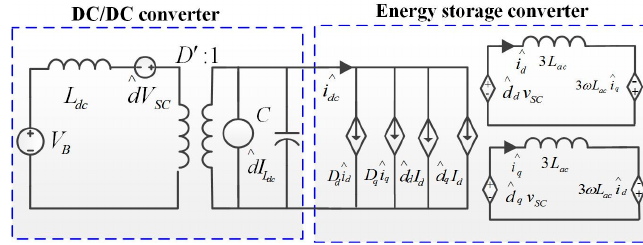
Figure 7. Small-signal equivalent model of converters.